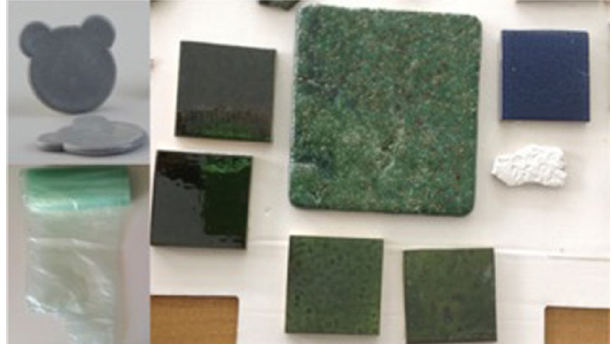
Figure 6. Pictures of several “green composites” realized by using the material produced with the COSMOS-RICE technology as a filler. It was inserted in polyethylene (30% in weight) and polyethylene foils (5% in weight). In addition, it was also employed to obtain tiles, with different colors (from 30% to 50% in weight).